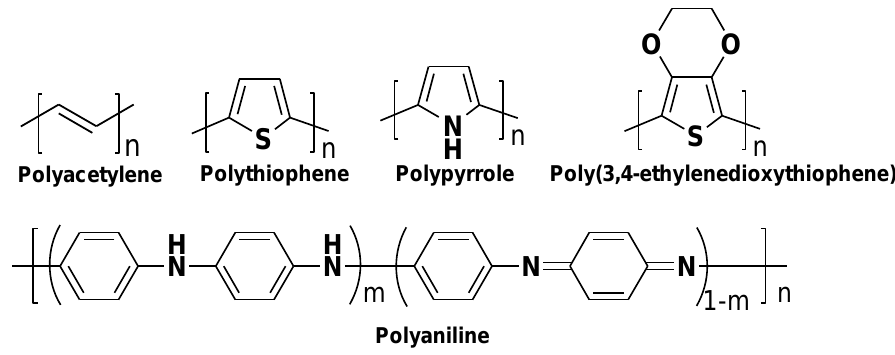
Scheme 1. Chemical formulae of most widely used conducting polymers.